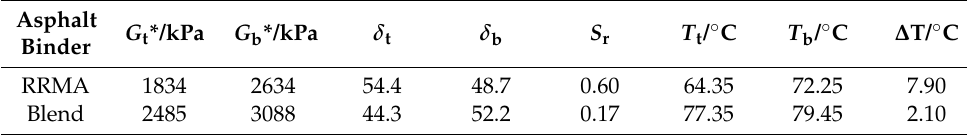
Table 2. DSR test results of RRMA and